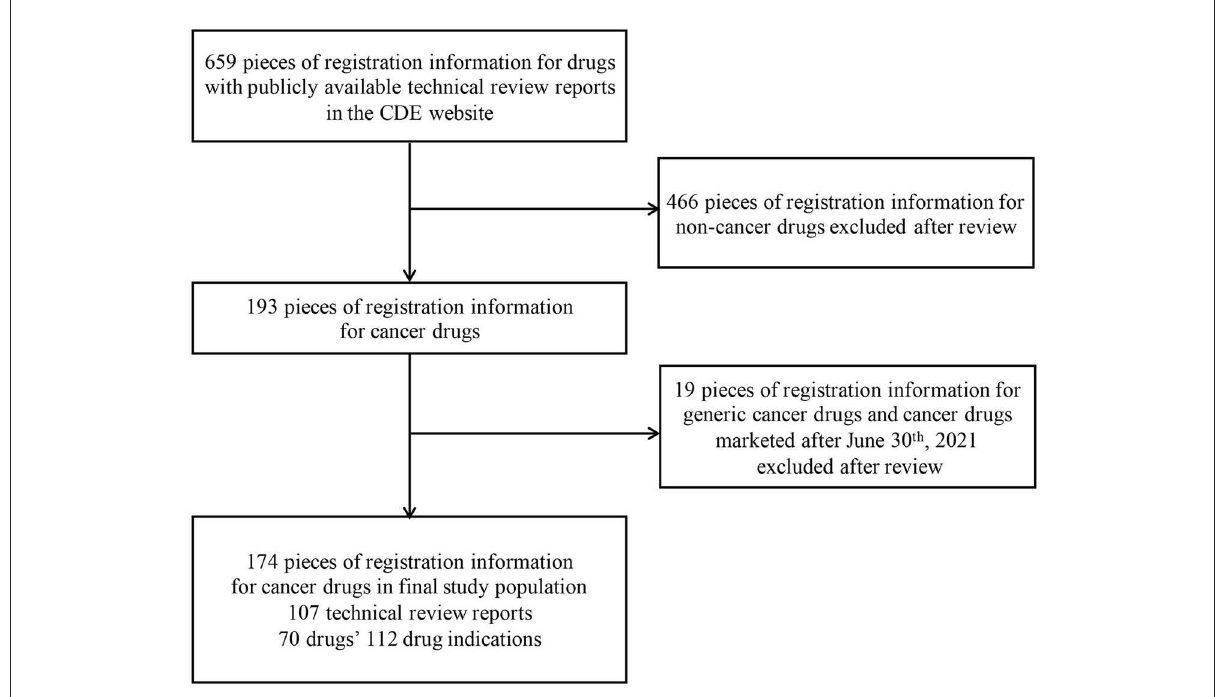
FIGURE1 Identification process for eligible drug indications for